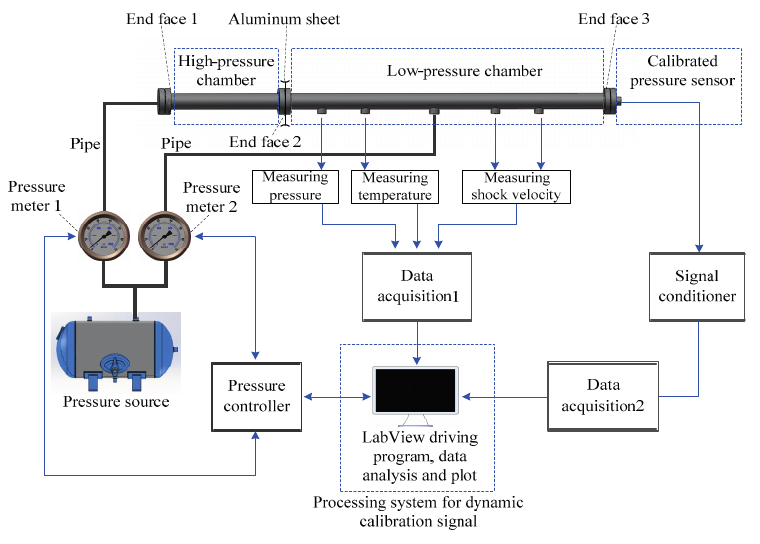
Figure 1. Schematic diagram of the shock tube calibration